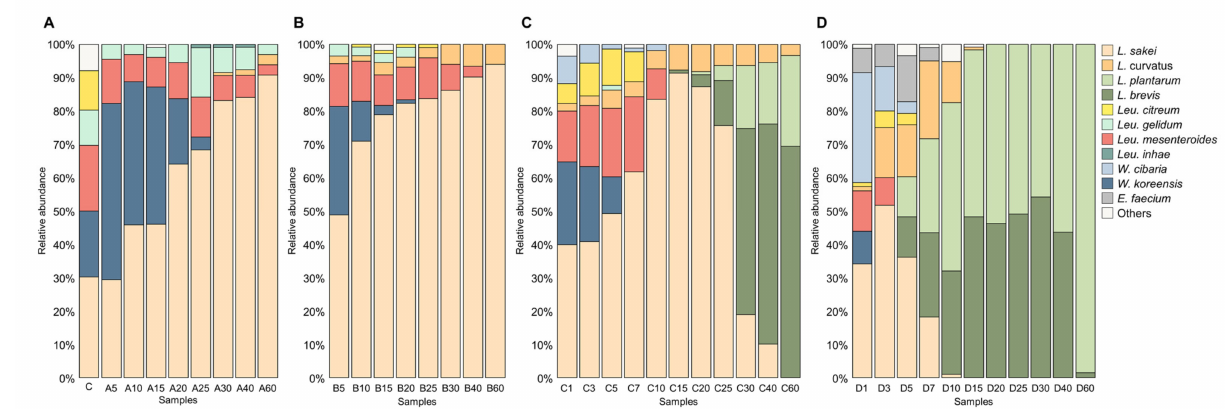
Figure 3. Changes in the LAB communities during the fermentation at ( A ) 5 ◦ C, ( B ) 10 ◦ C, ( C ) 15 ◦ C, and ( D ) 20 ◦ C. The graphs were generated by considering only the 3805 cultures identified at the species level (score ≥ 2.000). “Others” indicates species with a prevalence of 0.15%, including